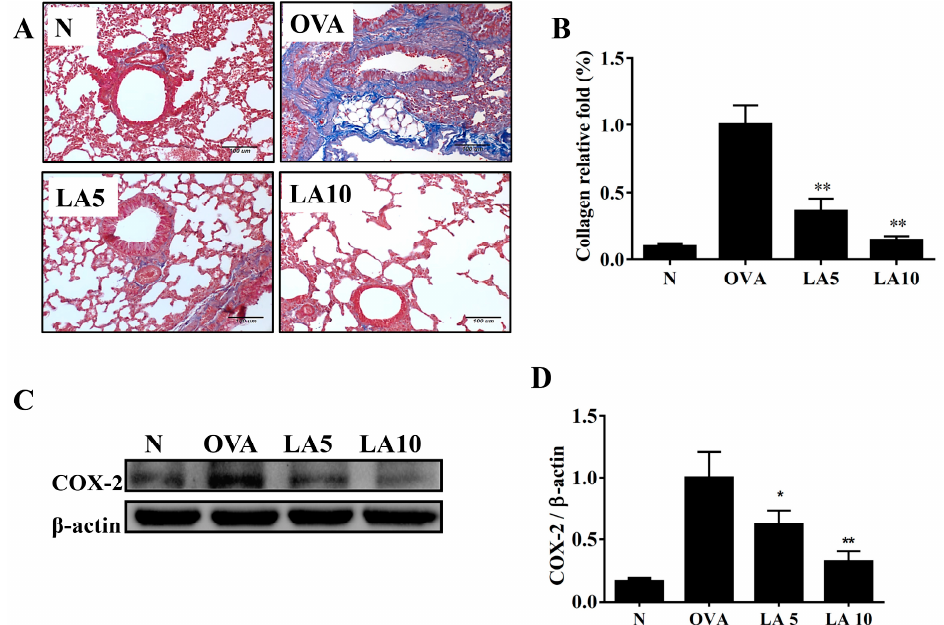
Figure 3. E ff ects of licochalcone A (LA) on collagen expression in lung tissue from OVA-sensitized mice. ( A ) Lung sections were stained with Masson’s trichrome stain to detect collage expression (200 × magnification). ( B ) Quantitative analysis of collagen in lung sections. ( C ) Western blot showing that LA suppressed COX-2 expression in lung tissue. ( D ) The fold-change in COX-2 protein expression was measured relative to the expression of β -actin. Three independent experiments were analyzed, and data were presented as mean ± SEM. * P < 0.05 compared to the OVA control group. ** P < 0.01 compared to the OVA control group.